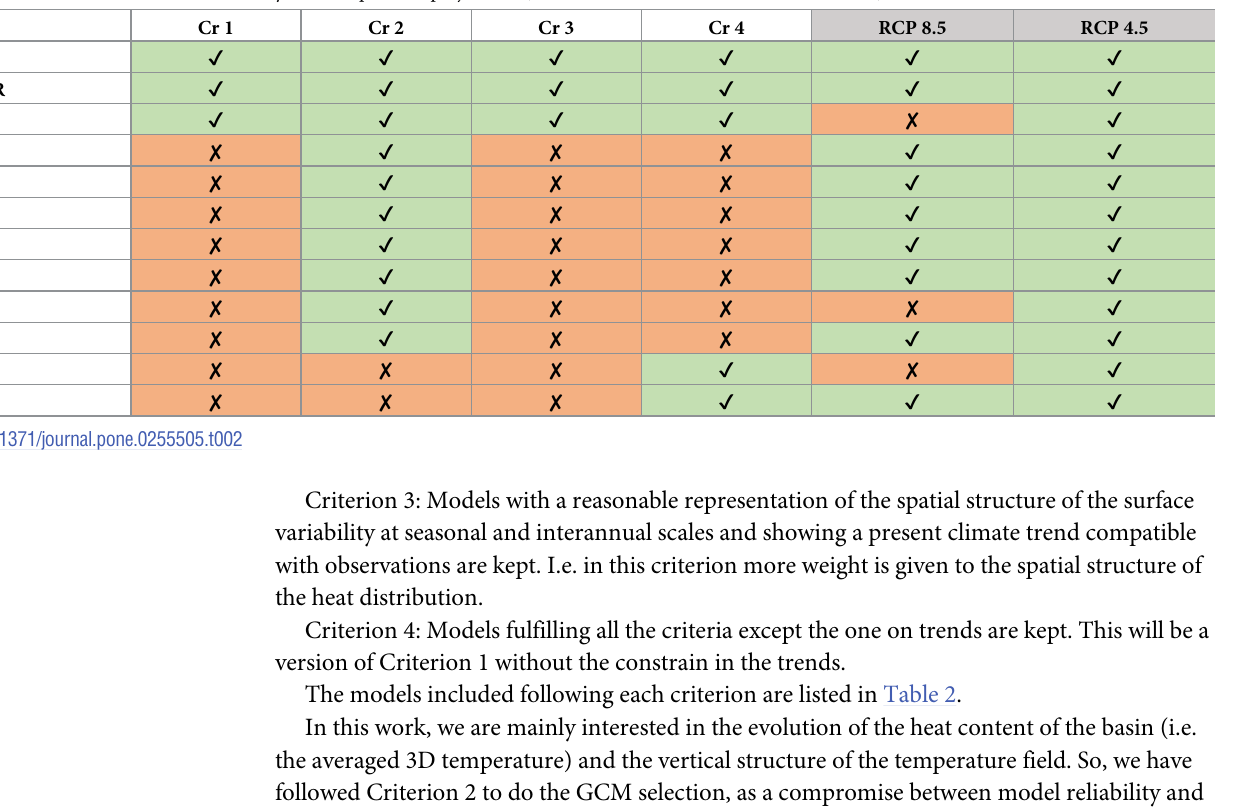
Table 2. List of GCMs that meet at least one of the criterion. The last two columns indicate whether the model has been run under scenario RCP8.5 and RCP4.5. In bold, the models that have been selected for the analysis of temperature projections (Criterion 2 and results for the two scenarios).